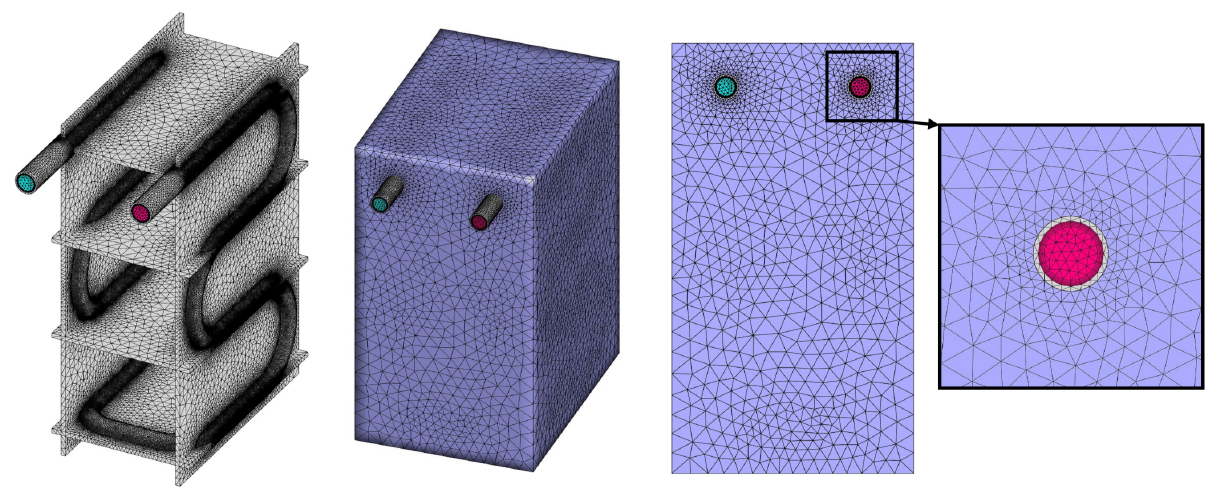
Figure 5. The final grid network for Case